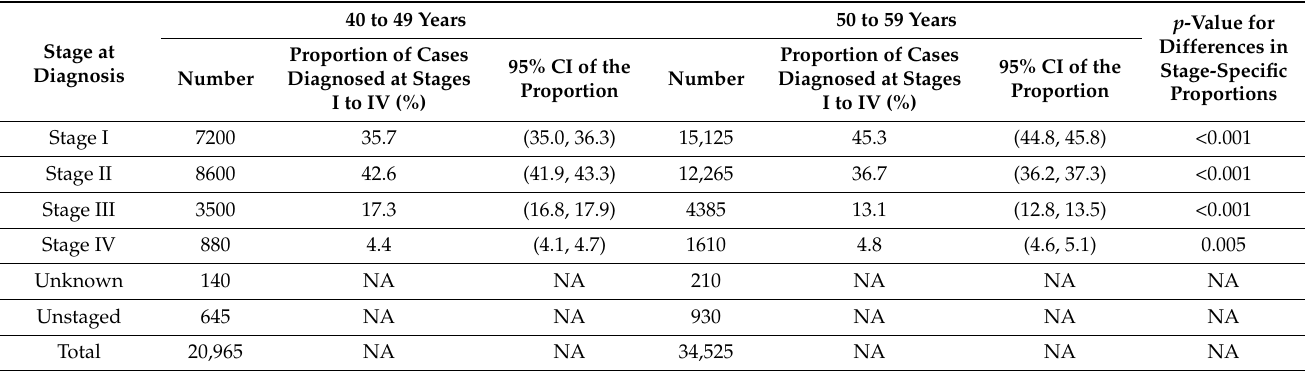
Figure 3. Stage – specific distribution of female breast cancer cases, ages 40 to 49 years versus ages 50 to 59 years, Canada excluding Quebec, 2010 to 2017. Note: Quebec is excluded because cases diagnosed in Quebec from 2011 onward had not been submitted to the Canadian Cancer Registry. Vertical error bars indicate 95% confidence intervals. Source: Canadian Cancer Registry (1992 to 2018) at Statistics Canada [42]. Table 2. Number and proportion of women diagnosed with breast cancer by stage at diagnosis, ages 40 to 49 years versus 50 to 59 years, Canada excluding Quebec, 2010 to 2017